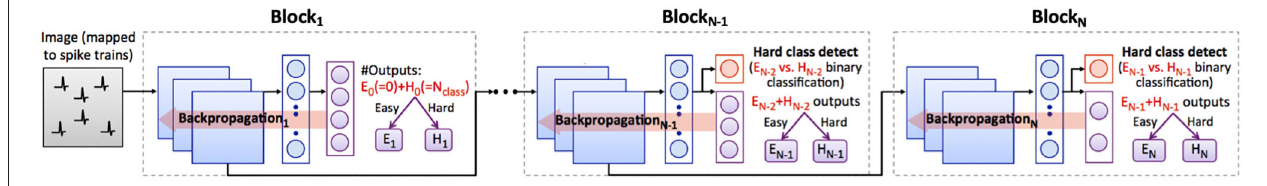
FIGURE 1 | Illustration of BlocTrain methodology for block-wise input complexity aware training of deep SNNs. The blocks are trained sequentially using local losses from the respective classifiers. Each block B i has a hard class detector that is trained to perform binary classification between the easy ( E i − 1 ) and the hard class instances ( H i − 1 ), as determined from the preceding block. The next block B i + 1 is trained only on the hard class instances ( H i − 1 ). This process is repeated for every block, leading to fast learning with increasing block